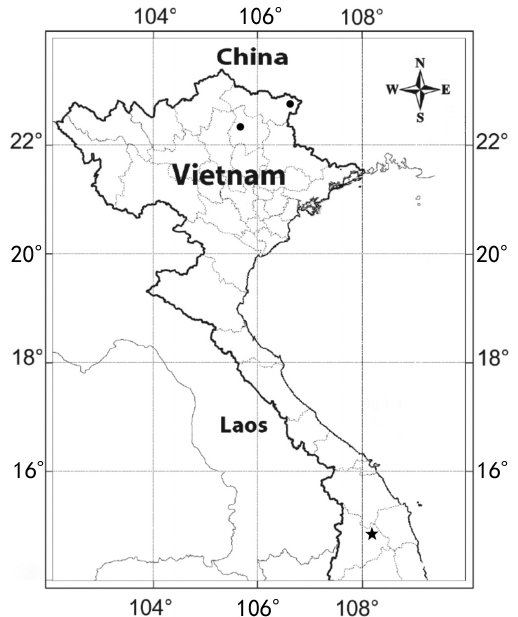
Figure 3. Distribution of C. japonica (dots) and C. procera (star) in